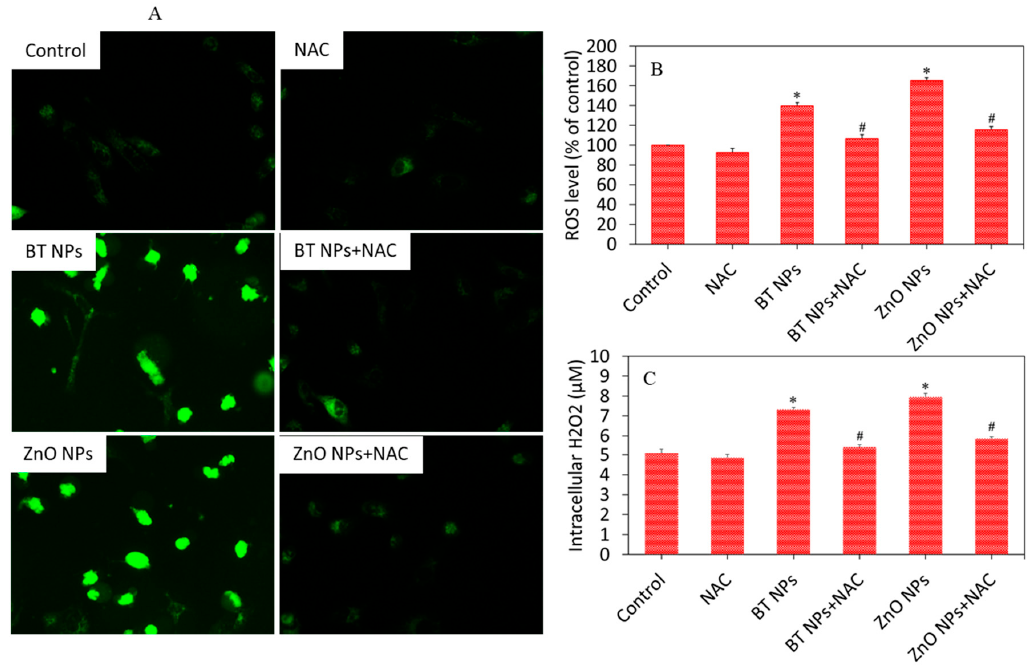
Figure 5. Pro-oxidant levels of A549 cells exposed for 24 h to 50 µg/mL of BT NPs with or without NAC (2 mM). ZnO NPs (25 µg/mL for 24 h) were used as a positive control. ( A ) Fluorescent microscopic images of DCF intensity in cells (an indicator of ROS generation). ( B ) Quantitative analysis of intracellular ROS level. ( C ) Quantitative analysis of intracellular H 2 O 2 level. Data are provided as mean ± SD of three independent experiments ( n = 3). * Indicates statistically significant difference from the control group ( p < 0.05). # Indicates that NAC effectively abrogated the effect of BT NPs or ZnO NPs.